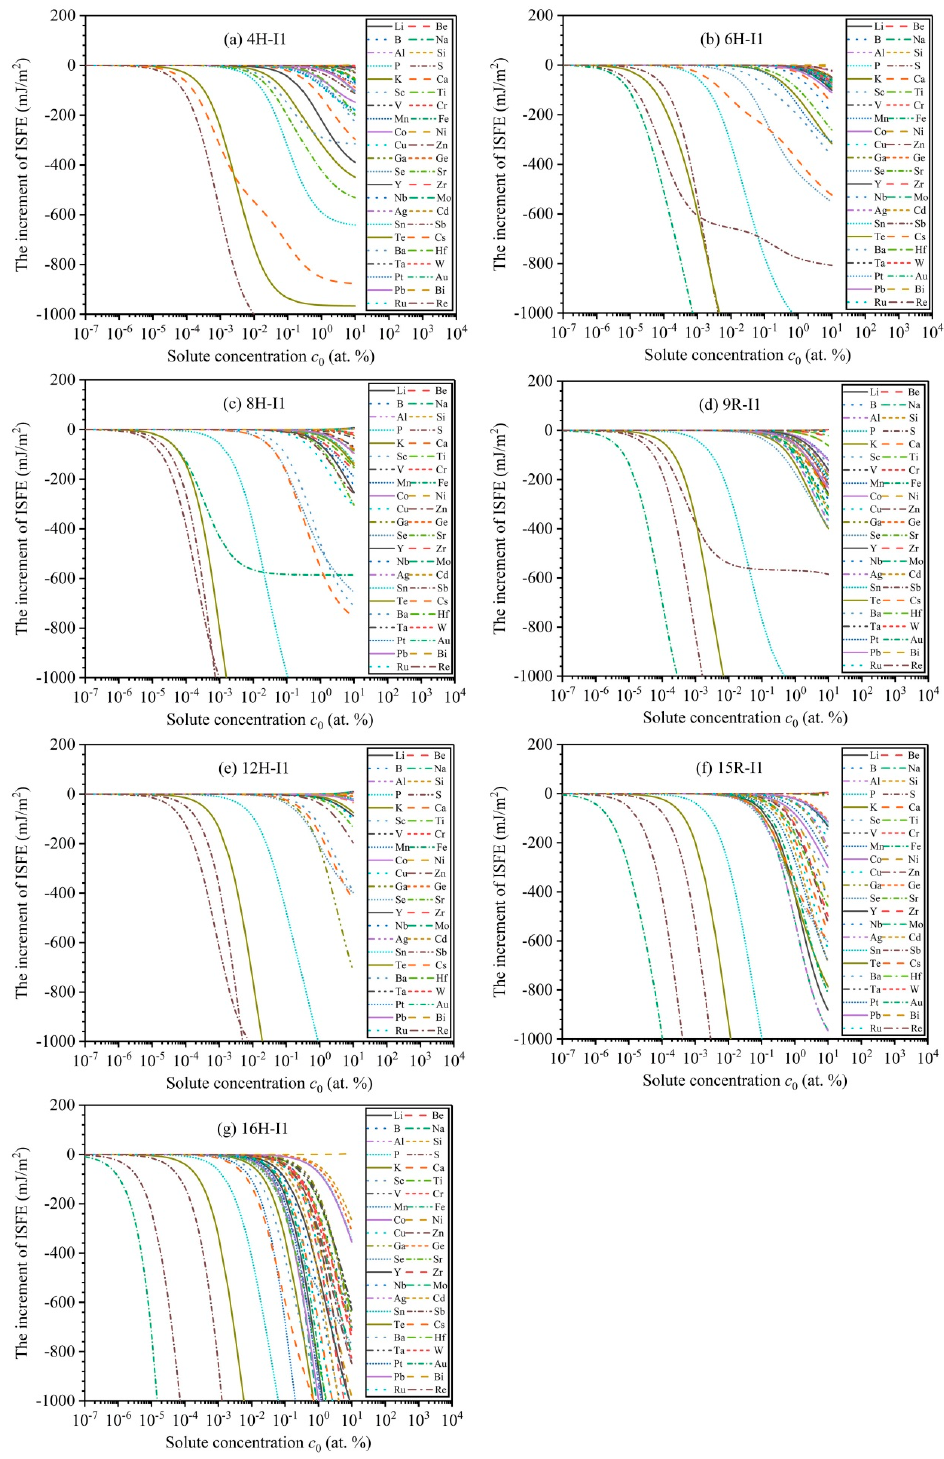
Figure 5. Variation curves of the increments of ISFEs as a function of solute concentrations c 0 at T = 300 K: ( a – g ) denote 4H, 6H, 8H, 9R, 12H, 15R, and 16H phases,